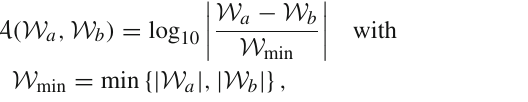
out special treatment of Gram determinants (“on-the-fly”) are stabilised using the permutation trick (139) for boxes (“perm”), exact analyticfor- mulas for triangles (“analytic”) and Gram-determinant expansions for δ < δ thr (“exp”). See Sect.